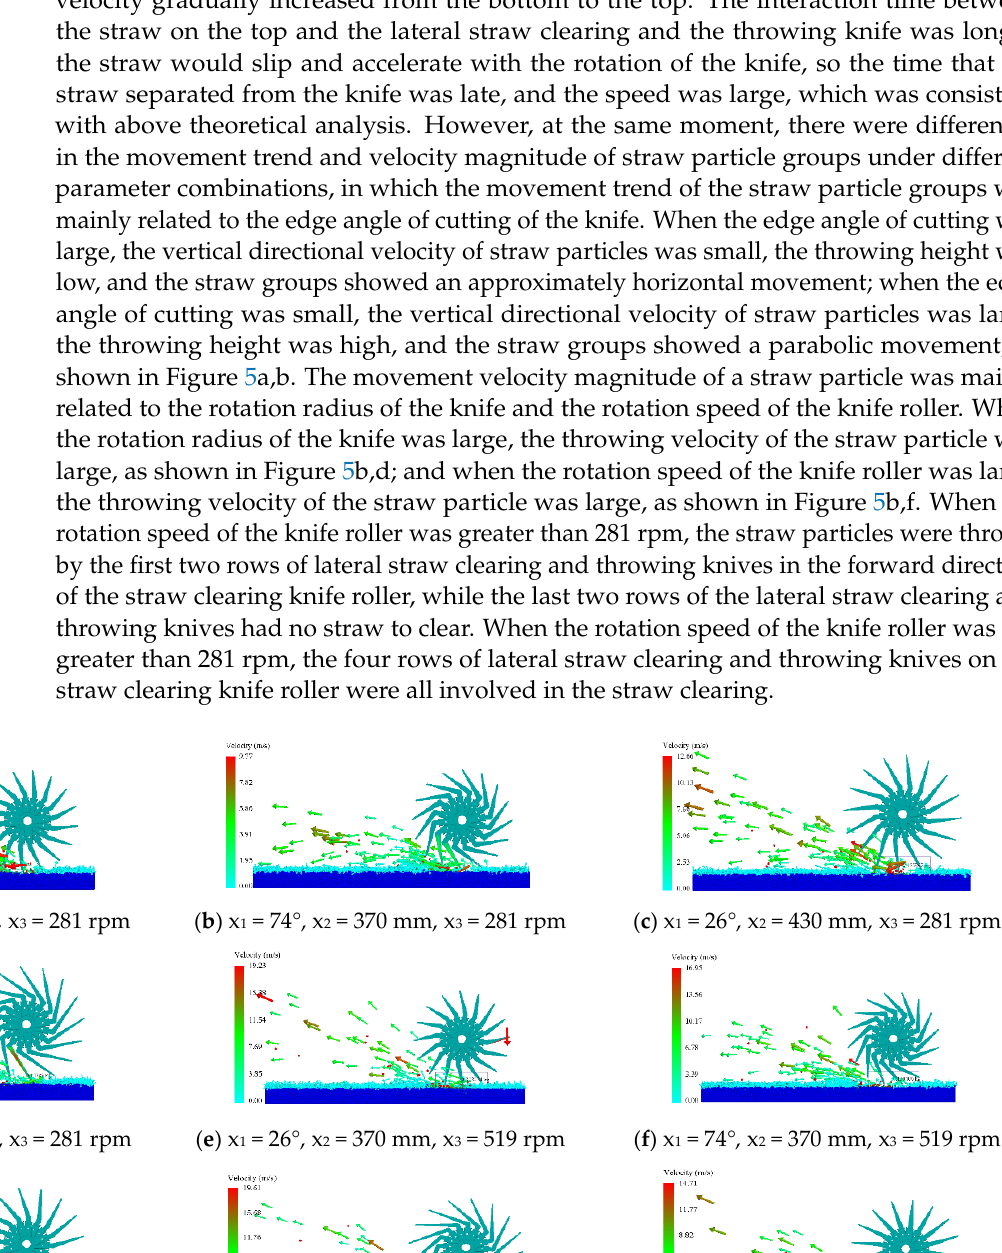
Figure 5. Velocity magnitude and position distribution of the lateral moving and throwing of the straw in discrete element simulation test. The Ansys module of Design-Expert 8.0.6.1 software was applied to perform variance (ANOVA) analysis on the test results, as shown in Table 3. The straw clearing rate model was significant, and the lack of fit was not significant; the power consumption model was highly significant, and the lack of fit was not significant, indicating that the equations of the straw clearing rate and power consumption were well simulated and could be used for the analysis and prediction of subsequent data. As for the straw clearing rate, the edge angle of cutting and rotation speed of the knife roller had significant effects, and the rota- tion radius of the knife and interactions among all factors had no significant effect. The contribution of each factor to the straw clearing rate, in descending order, was the edge angle of cutting, the rotation speed of the knife roller, and the rotation radius of the knife. As for power consumption, the edge angle of cutting and rotation speed of the knife roller had highly significant effects, the rotation radius of the knife had no significant effect, and the interaction between the edge angle of cutting and rotati on speed of the knife roller had significant effects. The contribution of each factor to power consumption, in descending order, was the rotation speed of the knife roller, the edge angle of cutting , and the rotation radius of the knife.